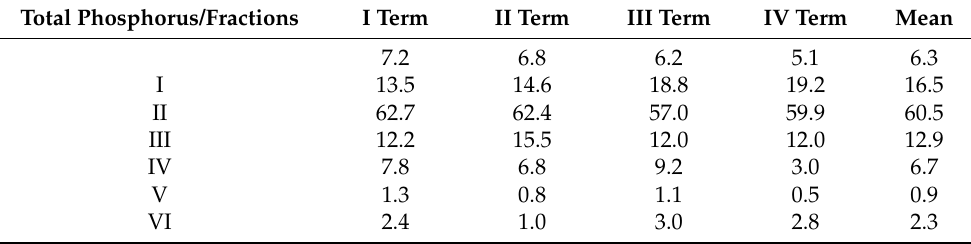
Table 3. Phosphorus content in g/kg DM and the fraction share (%) in the substrates before